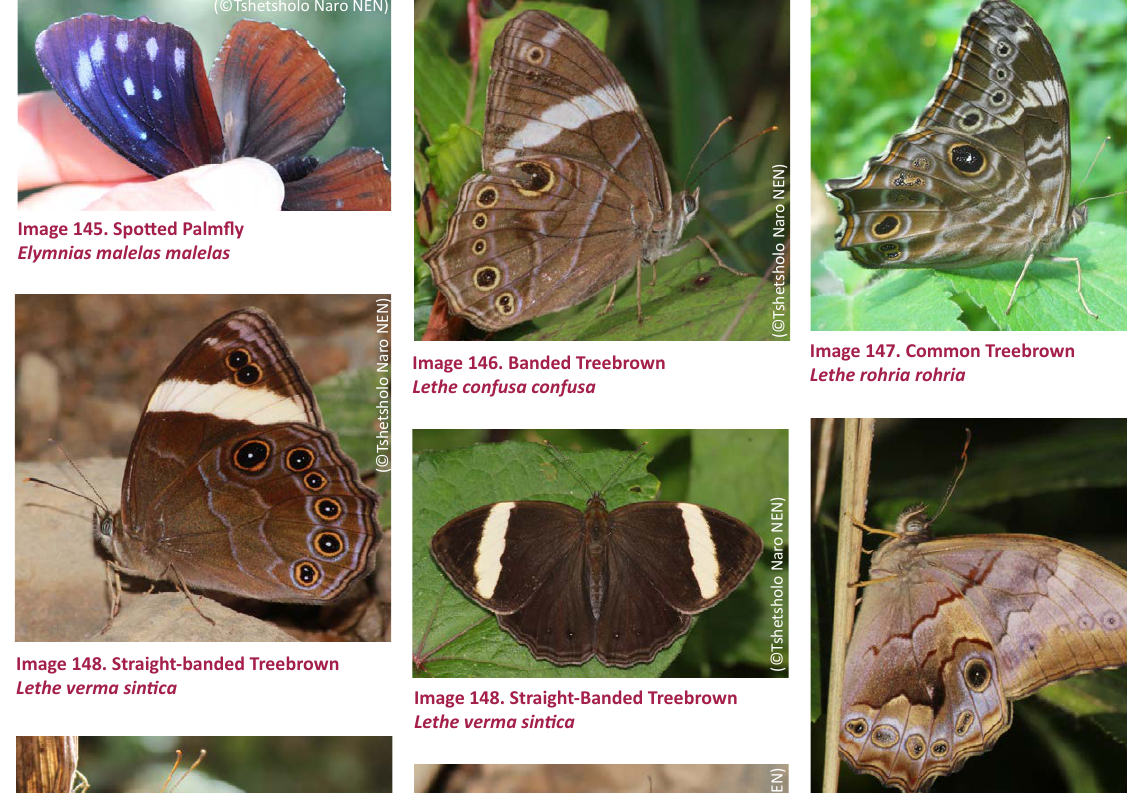
Image 149. Angled Red Forester Lethe chandica chandica